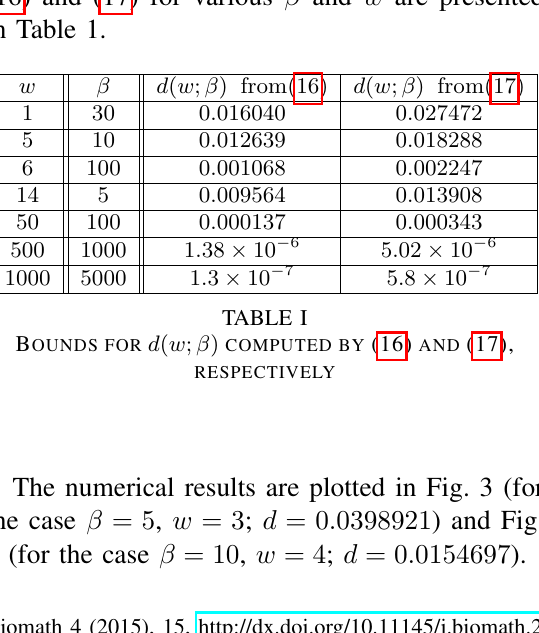
Fig. 4. Functions c δ,δ and s ( β ) 0 . 016